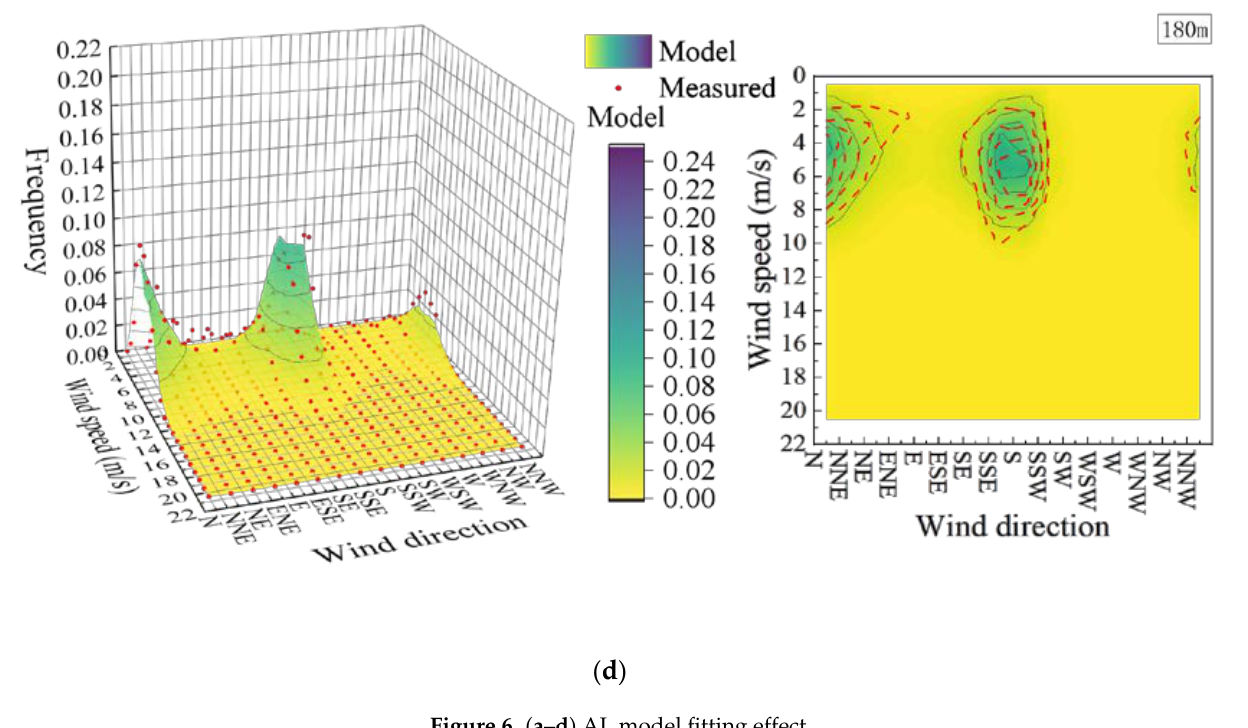
Figure 6. ( a – d ) AL model fitting effect. Table 9. Copula function parameter results and goodness of fit.